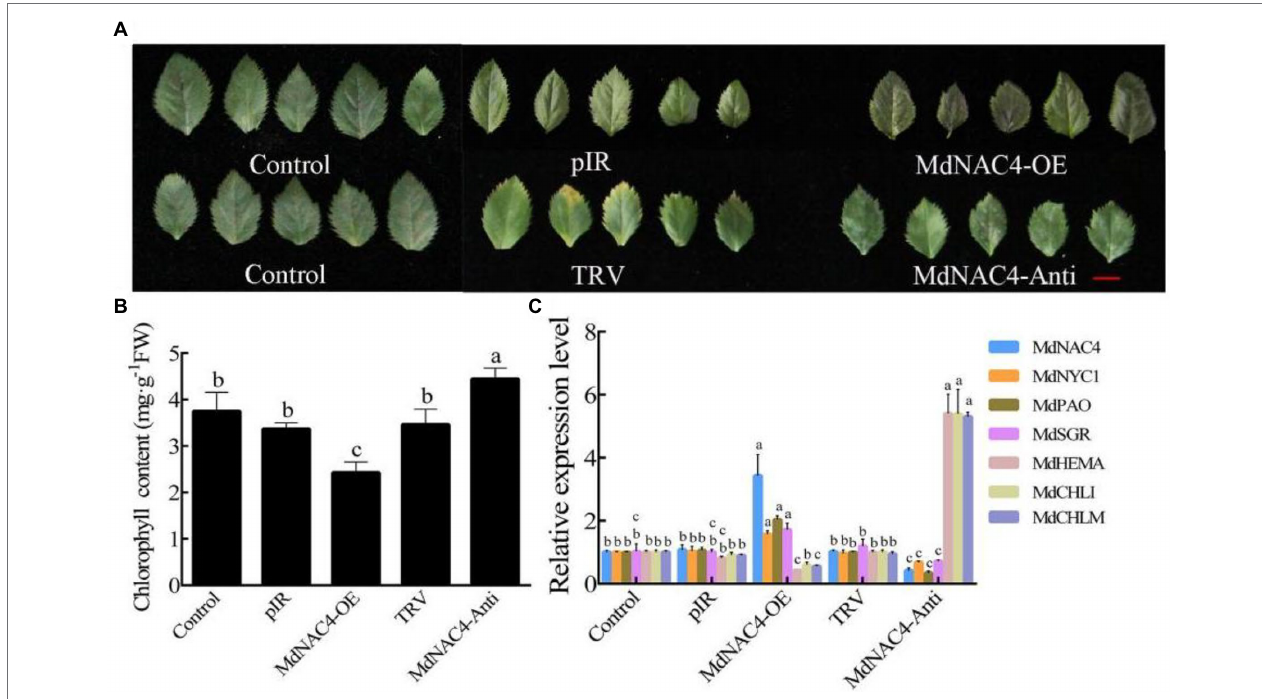
FIGURE 2 | Overexpression of MdNAC4 caused early senescence in apple leaves. (A) Phenotypes of apple leaves of WT (Control, pIR, TRV), MdNAC4 overexpression (MdNAC4-OE), and antisense MdNAC4 (MdNAC4-Anti) plants after 2 weeks of N-deficiency treatment; (B) Total chlorophyll content in apple leaves; (C) Expression levels of chlorophyll metabolism-related genes ( MdNAC4 , MdNYC1 , MdPAO , MdSGR1 , MdHEMA , MdCHLI , and MdCHLM ). pIR: IL60-1 + IL60-2; MdNAC4-OE: IL60-1 + MdNAC4-IL60-2; TRV: TRV1 + TRV2; MdNAC4-Anti: TRV1 + MdNAC4-TRV2. The data are expressed as the means ± SDs ( n = 3). The significance of the differences was tested by one-way ANOVA; p <